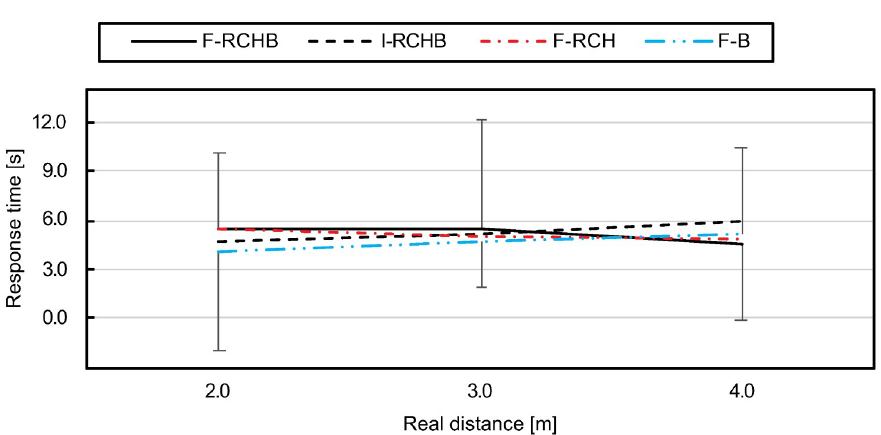
Fig 20. Response time. Mean and standard deviation of the response time depending on the real putting distance under the I-RCHB, F-RCHB, F-RCH, and F-B condition.